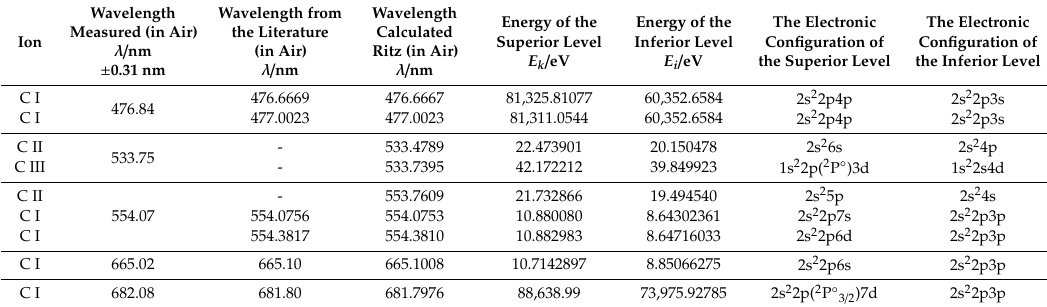
Table 2. Atomic carbon fluorescence (BPA in acetone solution with c = 1%).